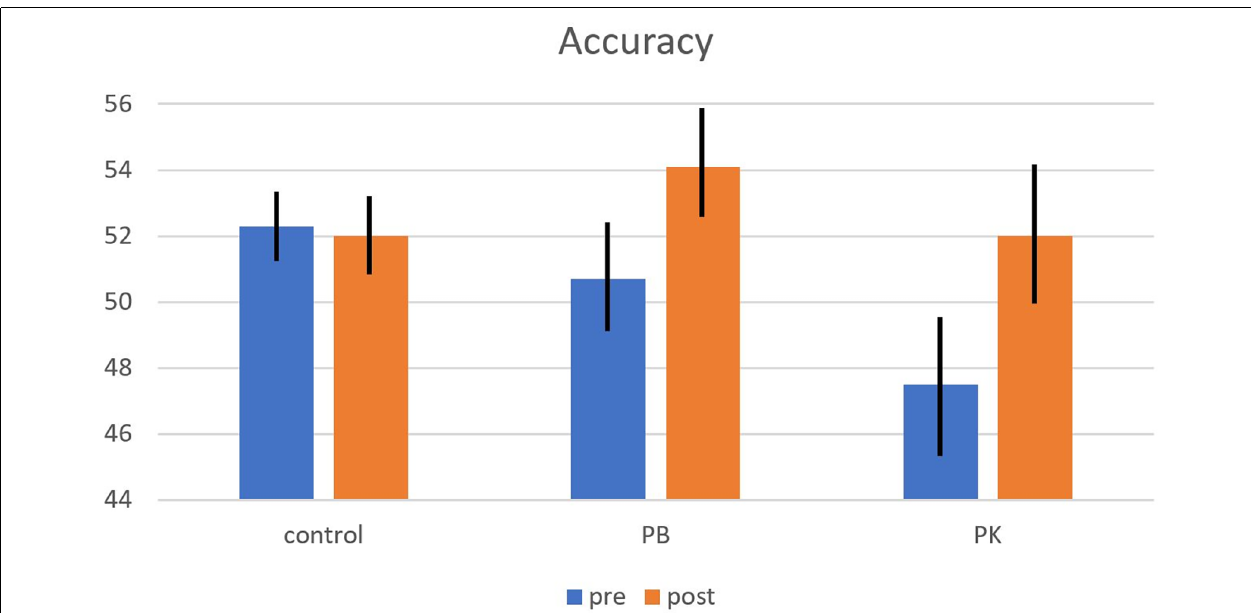
FIGURE 2 | Interaction of the effects of Group (X-axis) and Time (separate bars/violins) on penalty reading accuracy (Y-axis) in a bar graph (left panel) and a violin plot (right panel). Accuracy improved from pre- to post-test for both the PB and PK training groups, but not for the control group. Error bars (left panel) represent 1 standard error to the